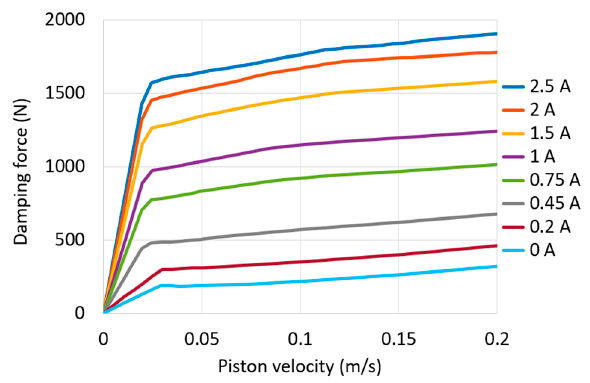
Figure 4. Measured F-v-I map of the used damper.